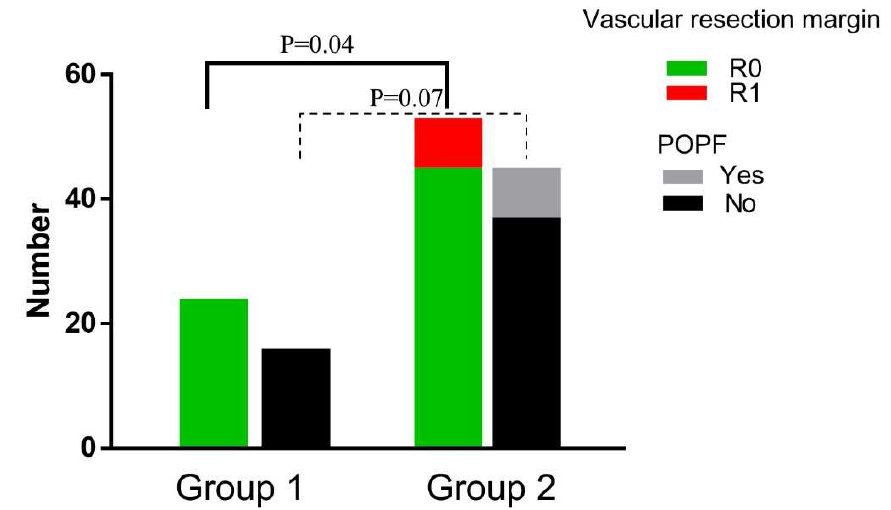
Figure 2. Perioperative data compared between the groups. The vascular resection margin was compared between Group 1 and Group 2 receiving PD and TP; POPF was compared between Group 1 and Group 2 receiving PD. Abbreviations: POPF, postoperative pancreatic fistula. PD, pancreaticoduodenectomy. TP, total pancreatectomy. Table 2. Comparison of the general information between patients with PD of the two groups.